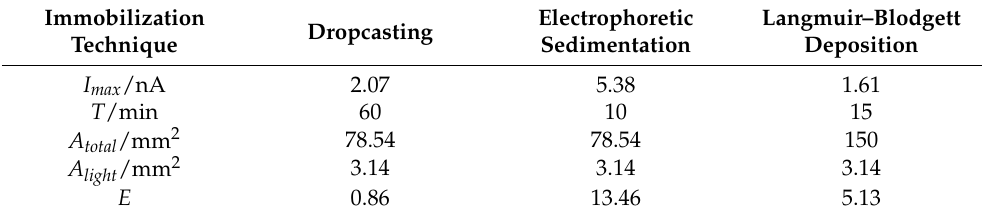
Table 1. Efficiency factors of the different immobilization